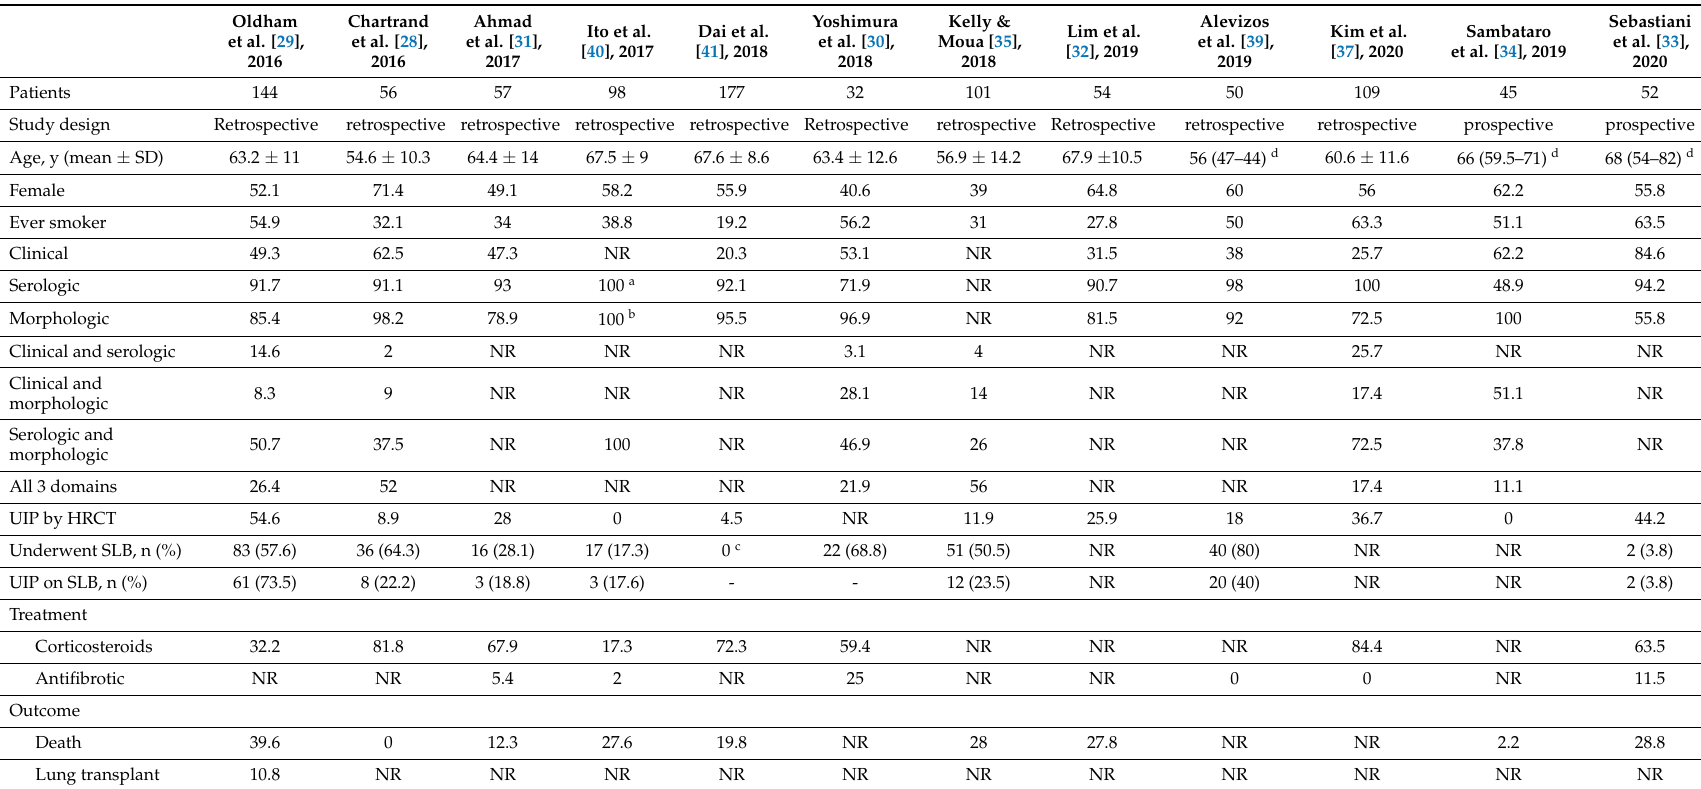
Table 2. Comparison of retrospectively and prospectively identified interstitial pneumonia with autoimmune features (IPAF)